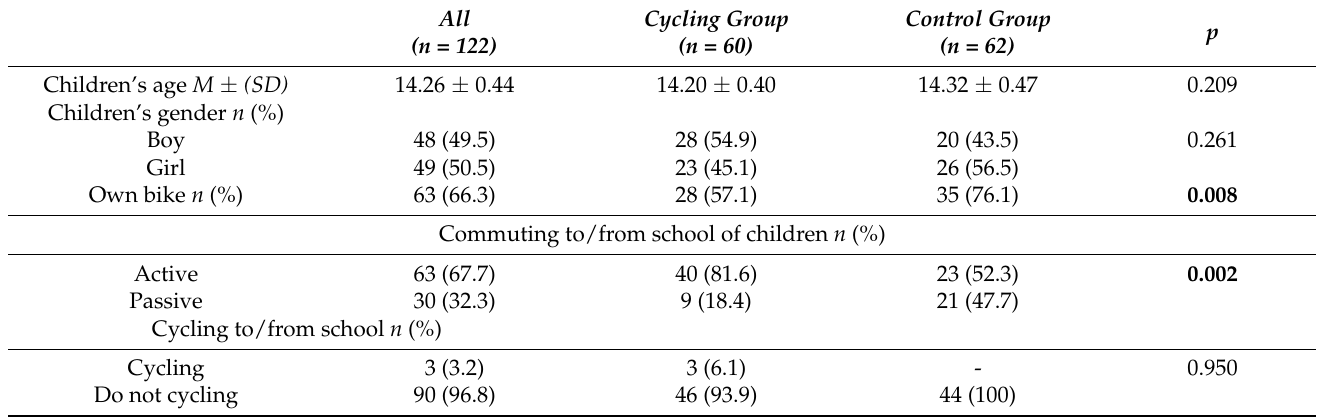
Table 1. Descriptive data of the participants from the cycling and control group at baseline (intention to treat